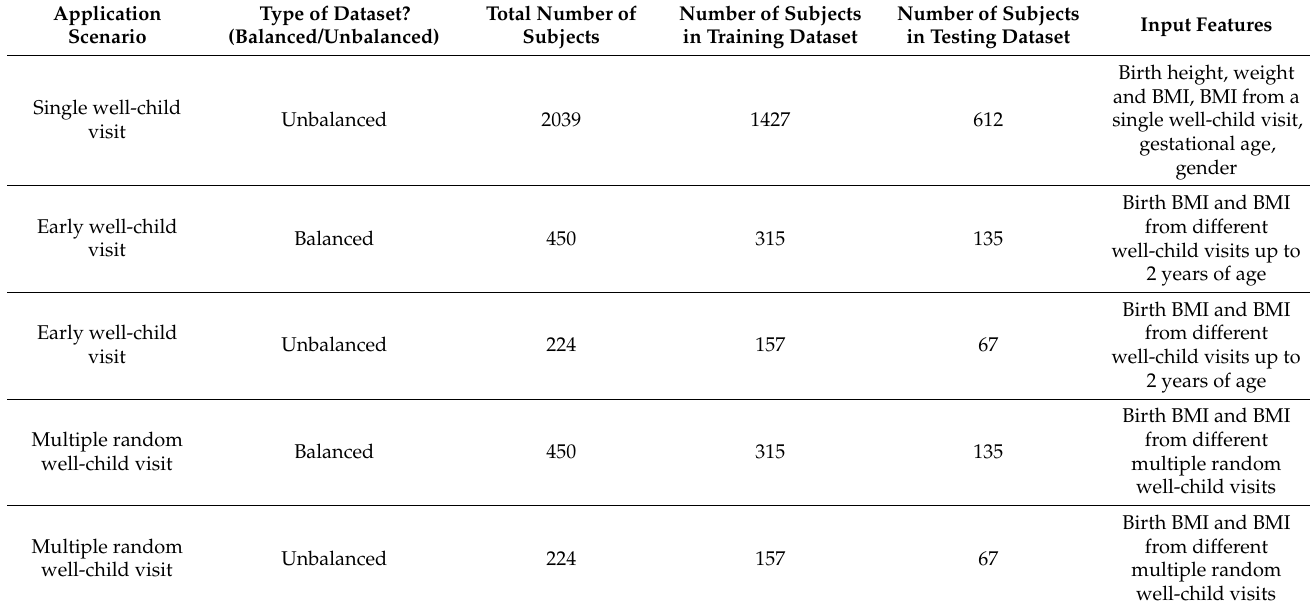
Table 1. Dataset size, dataset type, and the input features of different application